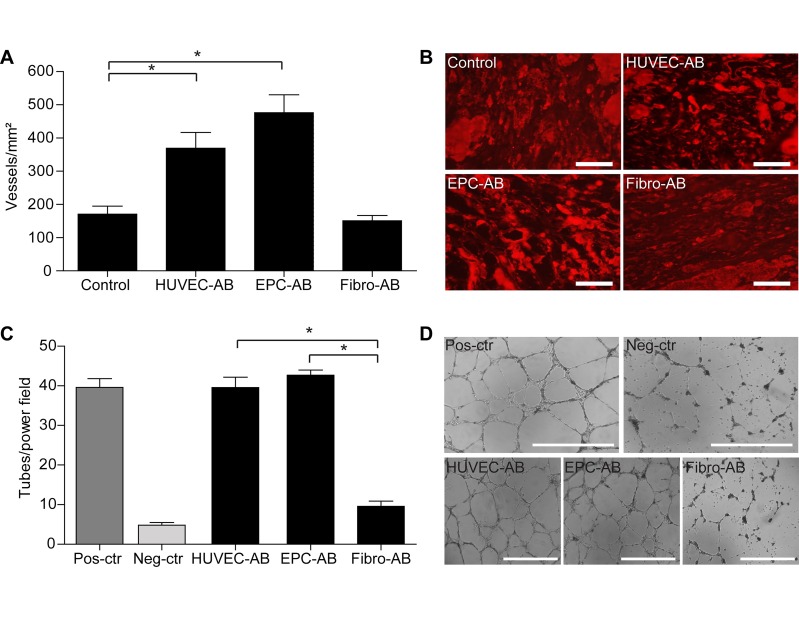
Analysis of angiogenesis in the infarcted areasThe quantification of CD31-positive vessels (red) reveals significant differences in the control group compared with EPC-AB and HUVEC-AB group, but not with Fibro-AB group (A, *p<0.05). Representative pictures from infarction areas are shown (B, Scale bar 25µm). In vitro matrigel experiments showed that apoptotic bodies from HUVEC and EPCs were able to induce tube formation, but not the apoptotic bodies from fibroblasts (C, *p<0.05). Representative pictures from positive control group (Pos-ctr, incubated with VEGF-rich medium), negative control group (Neg-ctr, incubated with 1%BSA), as well as from EPC-AB, HUVEC-AB and Fibro-AB groups were showed (D, Scale bar 1000µm).